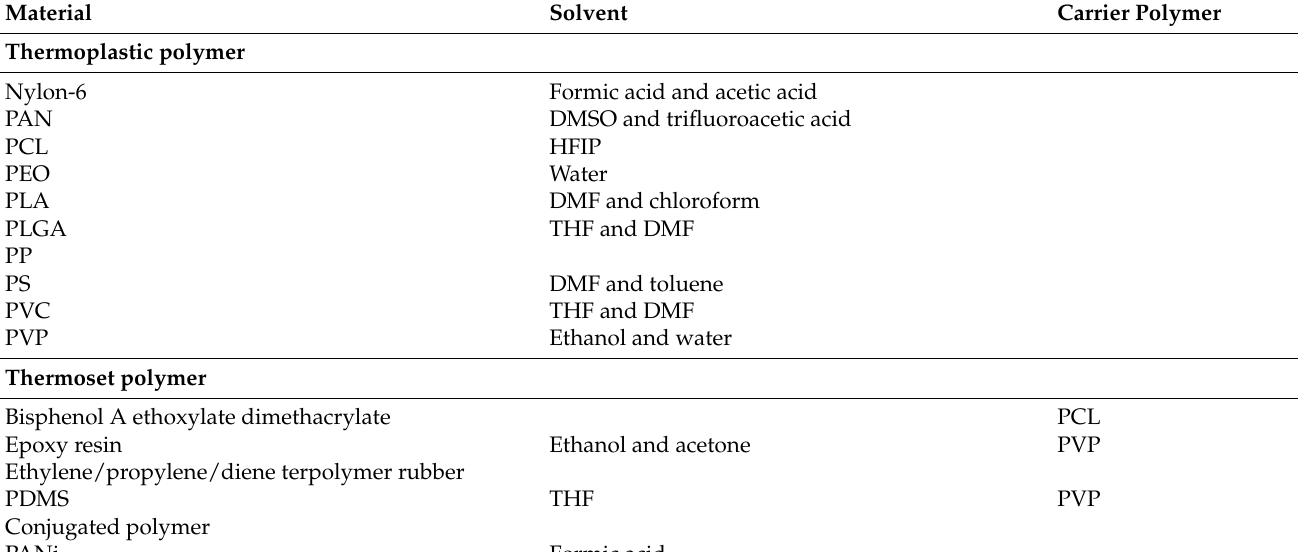
Table 1. Electrospun polymers, solvents used and carrier if corresponding. Adapted with permission from Xue et al. [23]. Copyright © 2019, American Chemical